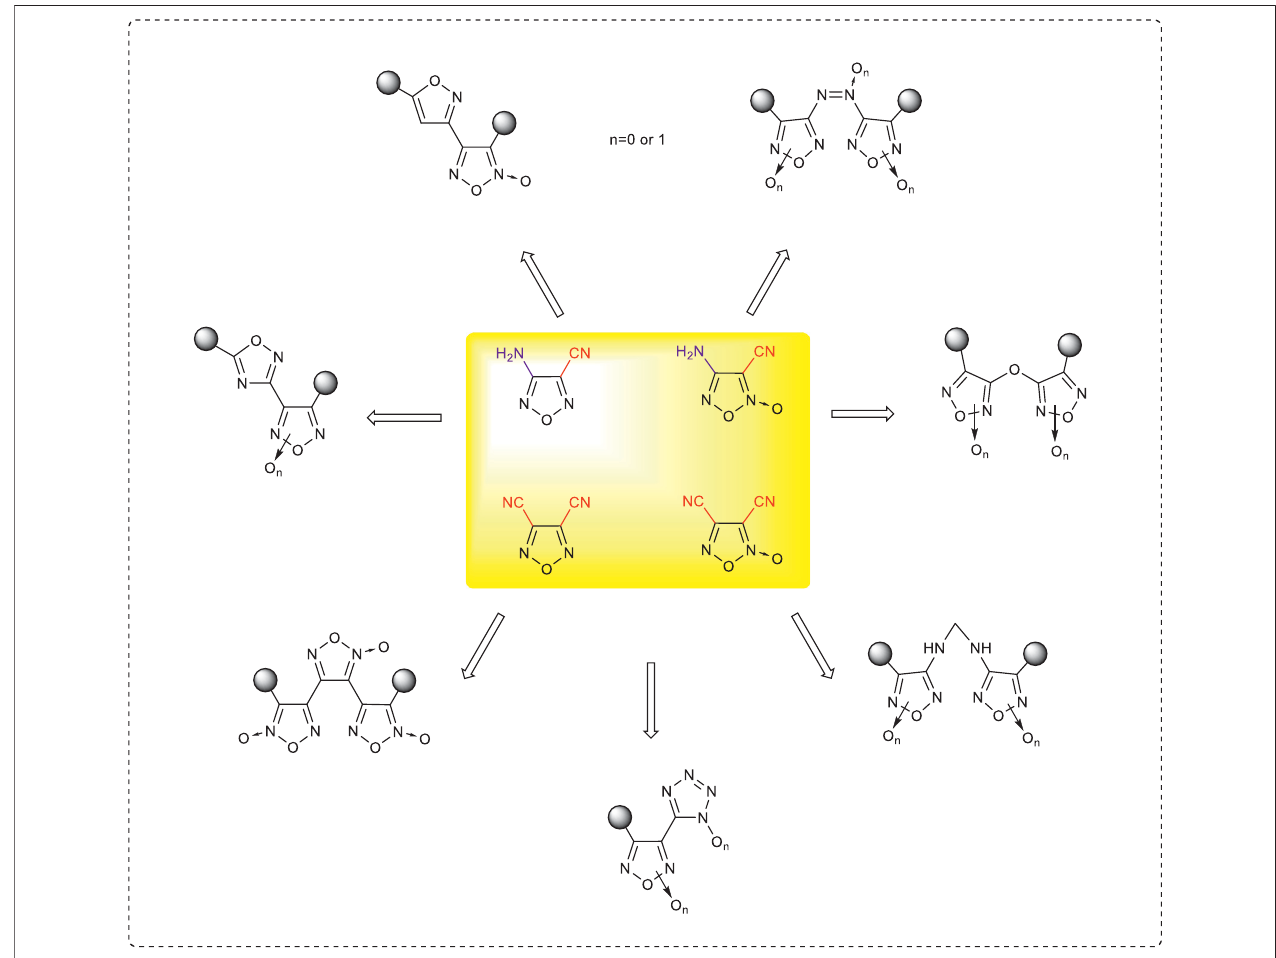
FIGURE 1 | Synthetic strategies toward nitrogen-rich frameworks based on cyanofurazans/furoxans.